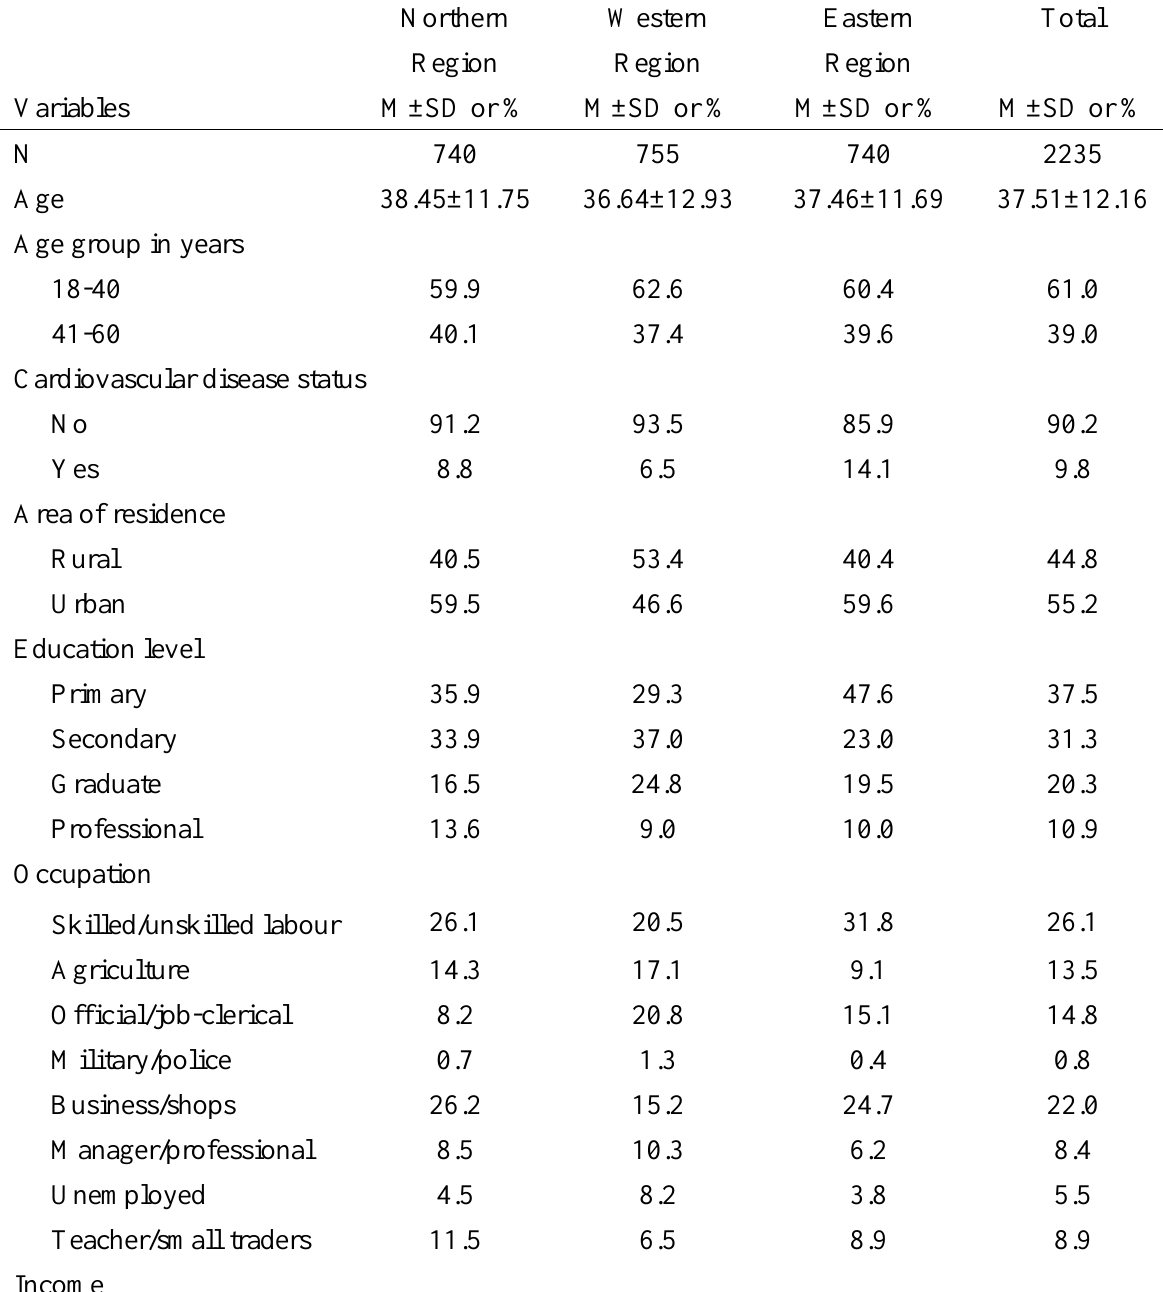
Table 1. Percent distribution of respondents by socioeconomic characteristics and lifestyle